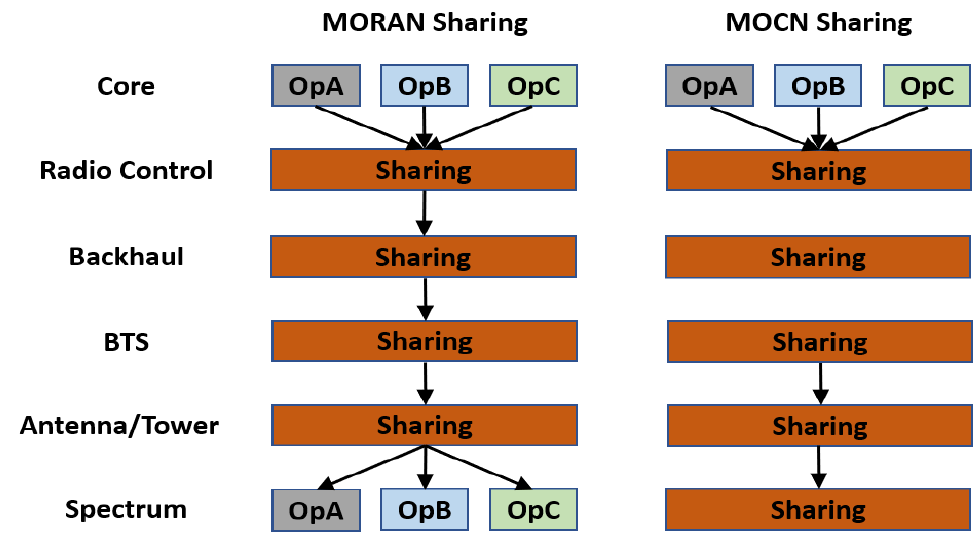
Figure 2. MORAN and MOCN active sharing between three operators.